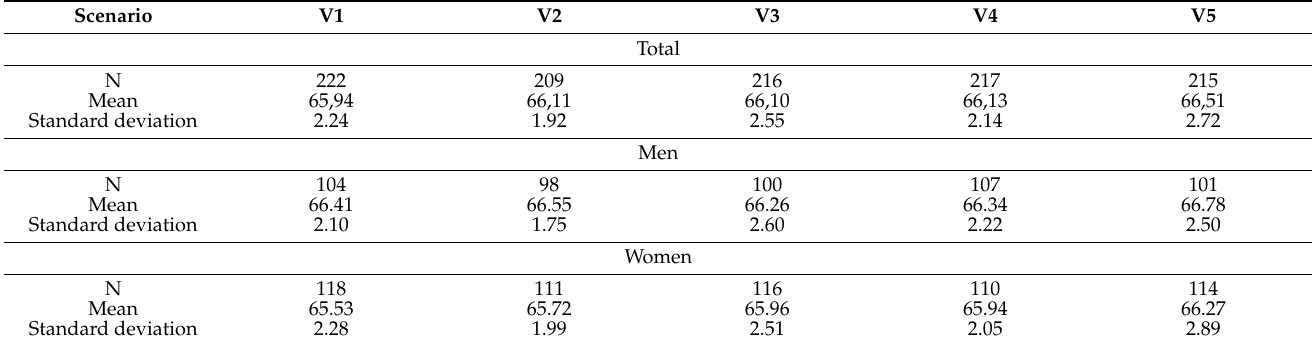
Table A2. Average Planned Retirement Age Under Different Framing